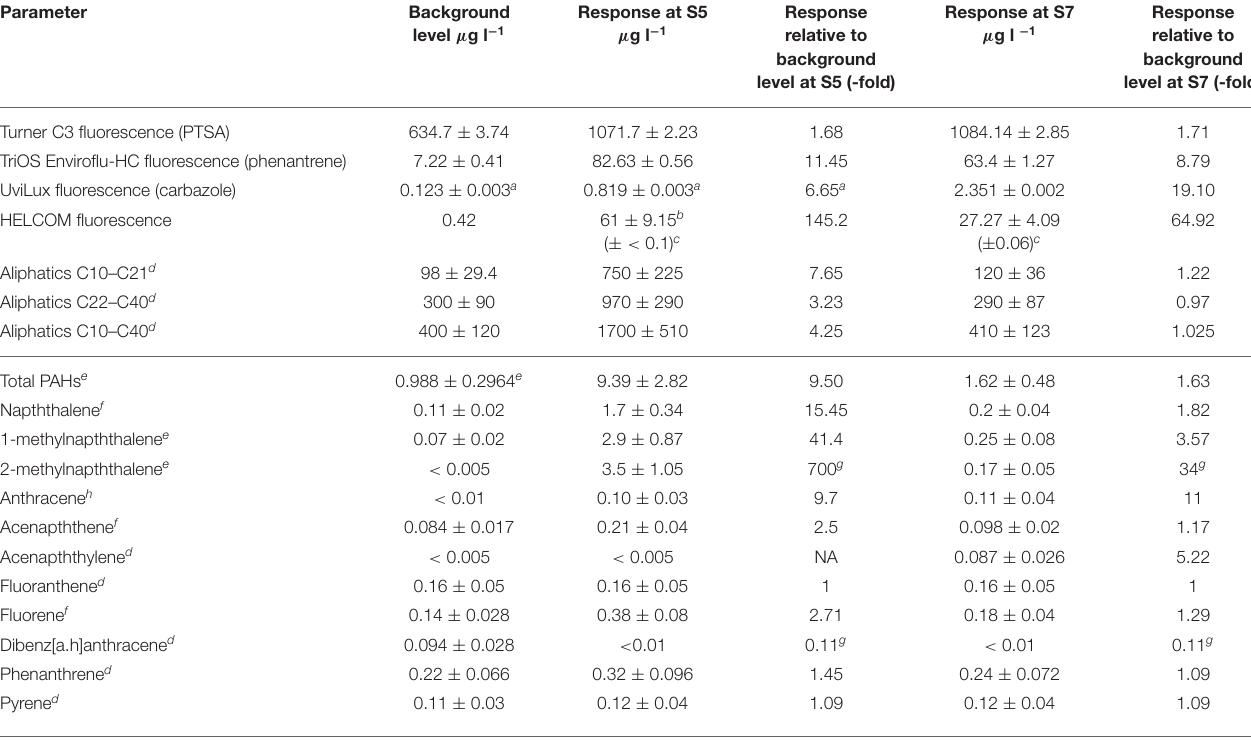
TABLE 2 | Overview on the response levels generated by the fluorescence-based methods and parameters obtained from GC–FID and GC–MS